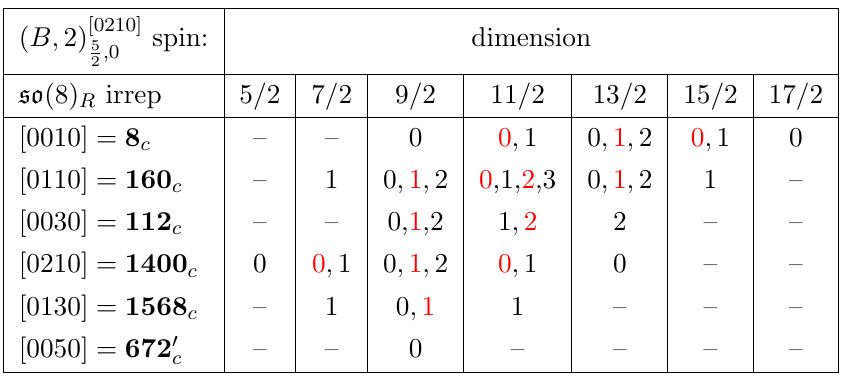
Table 15 . All possible conformal primaries in S 2 (cid:2) S 3 corresponding to the ( B; 2) [0210] formal multiplet.